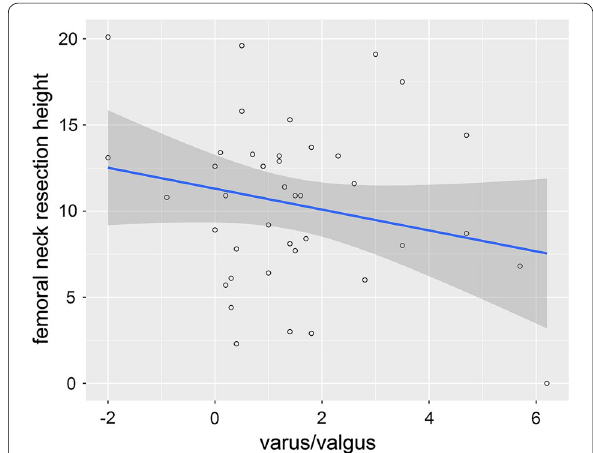
Fig. 7 The scatterplot shows the correlation between varus/valgus alignment and femoral neck resection height. The blue line indicates the linear regression line and the dark grey area the corresponding the 95% CI